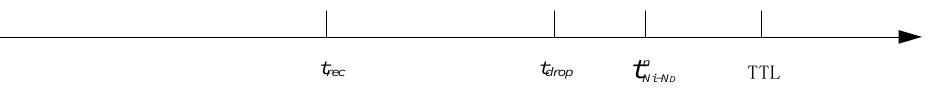
Figure 6. Dropping a message deliberately.